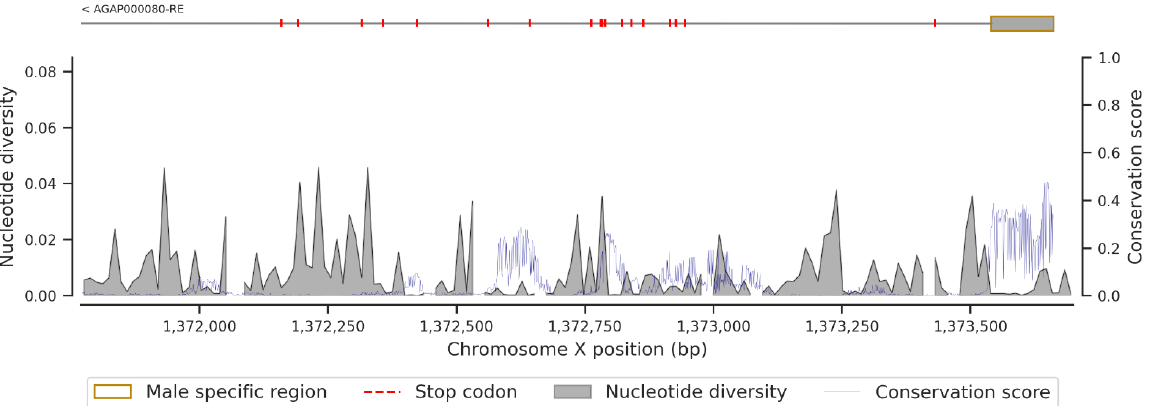
Figure 5. Conservation score and nucleotide diversity in a window of 12 bp within the sex-specific region of the Fruitless gene. The upper figure is the sex-specific region of the Fruitless gene (rectangle corresponds to the male-specific region, rectangle and simple line correspond to the female-specific region, and red dashes are the probable stop codon within the female-specific region); lower figure is the conservation score (blue line) and the nucleotide diversity (dark fill) plot.